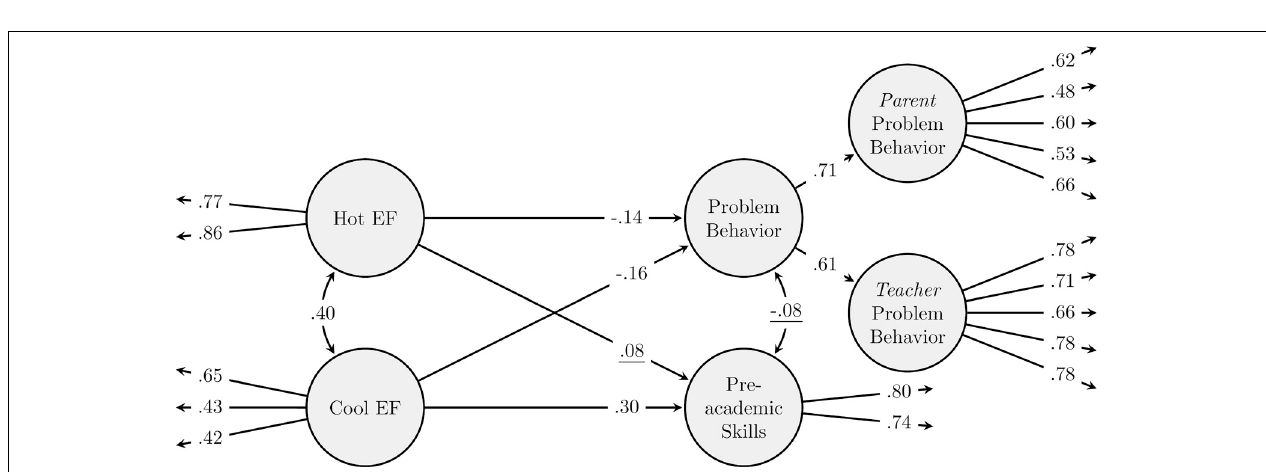
model: Association between cool and hot EF and report-based attention. Age, gender, SES, home language, and cohort were included as covariates in the model.